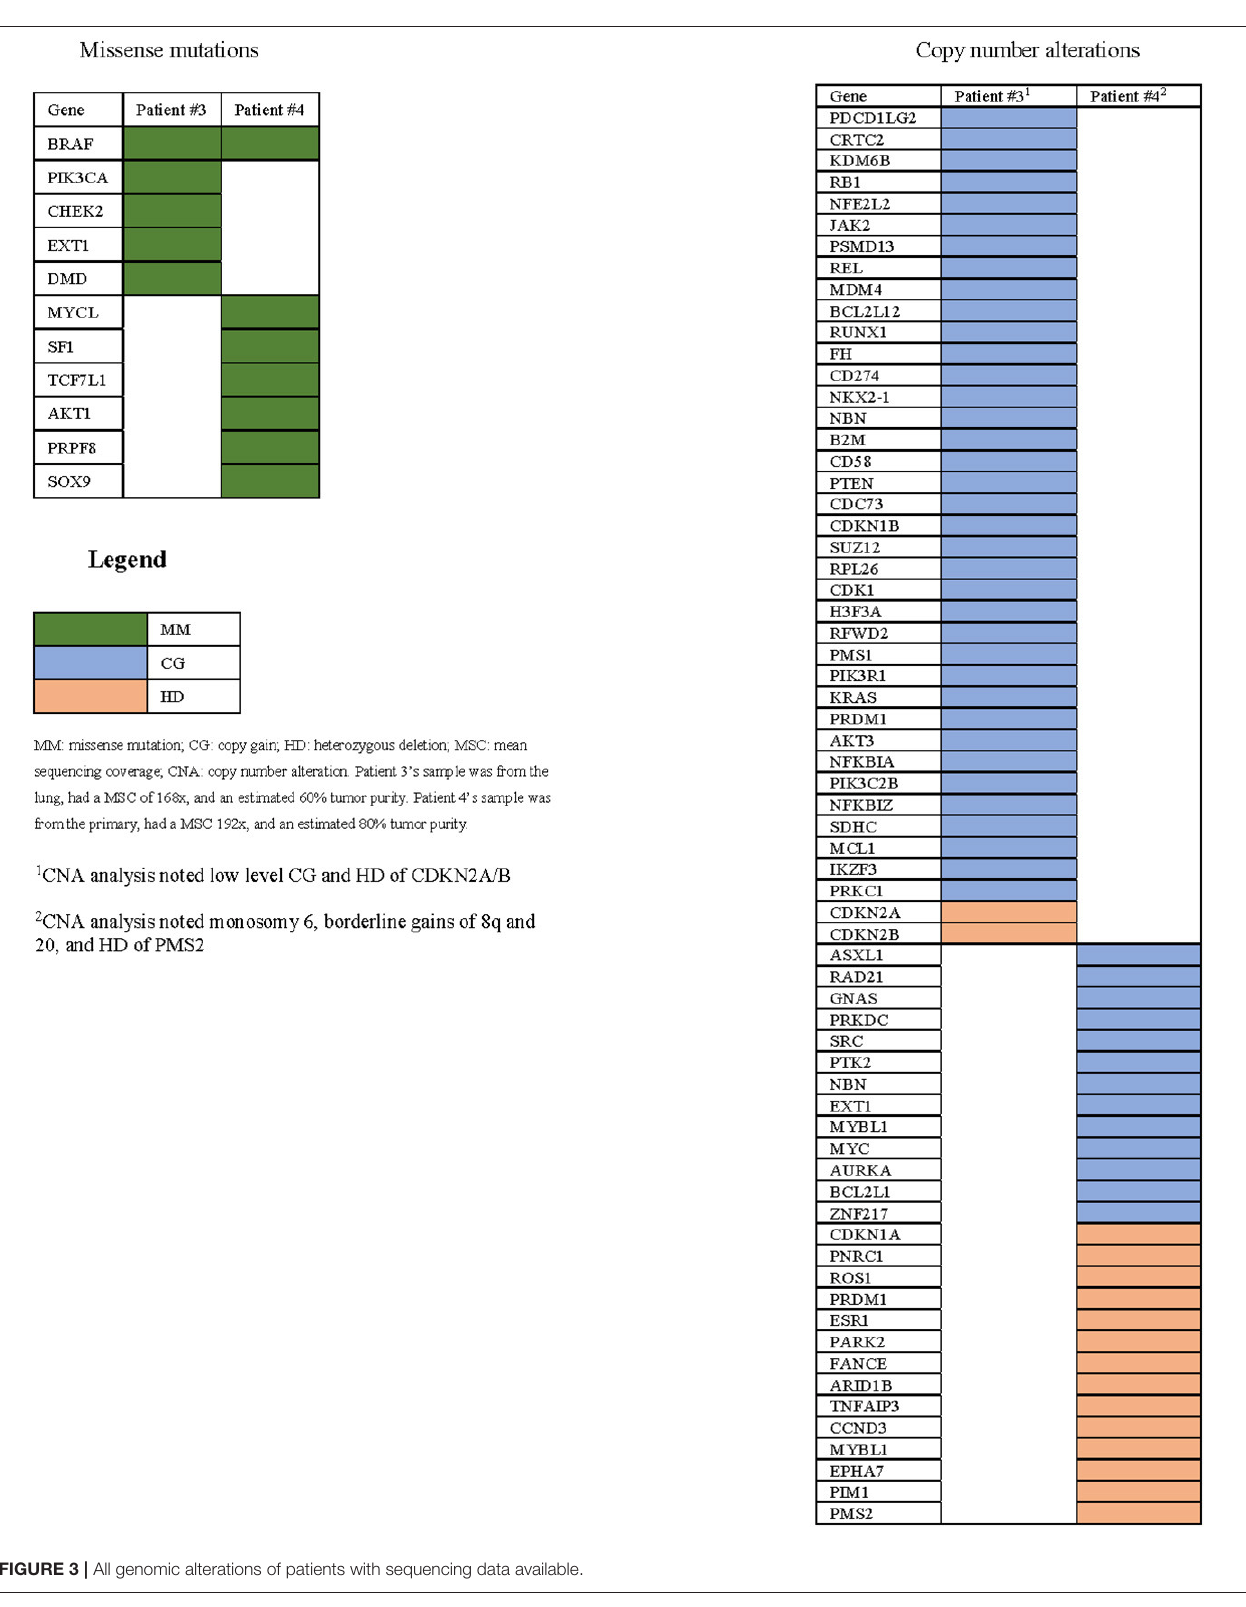
Frontiers in Oncology |